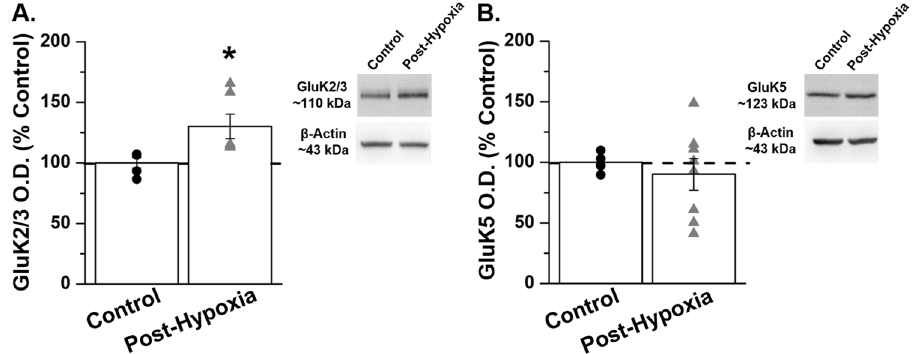
Figure 4. GluK2/3 subunit expression is significantly increased in area CA3 of the neonatal mouse post- hypoxia. ( A ) Expression of GluK2/3 is significantly increased in area CA3 of the neonatal mouse 1-hour post in vivo hypoxia. ( B ) GluK5 subunit expression is not altered in area CA3 1-hour post in vivo hypoxia in the neonatal mouse. n = 5–8 pooled samples (microdissected CA3 regions from two littermate pups, n = 1); * p = 0.031, t- test. Data shown as percent mean ± SEM. Please see Supplemental Fig. S2 for full-length gel